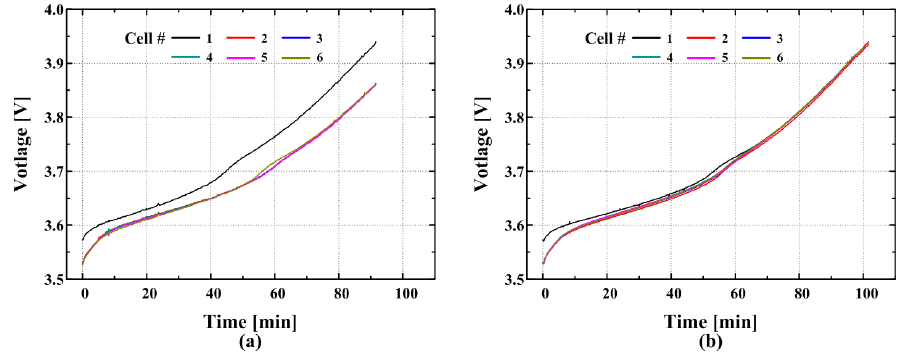
Figure 10. Voltage versus charging time for the battery pack: ( a ) pack-to-cell balancing in charging operation and ( b ) cell-to-pack balancing in charging operation.